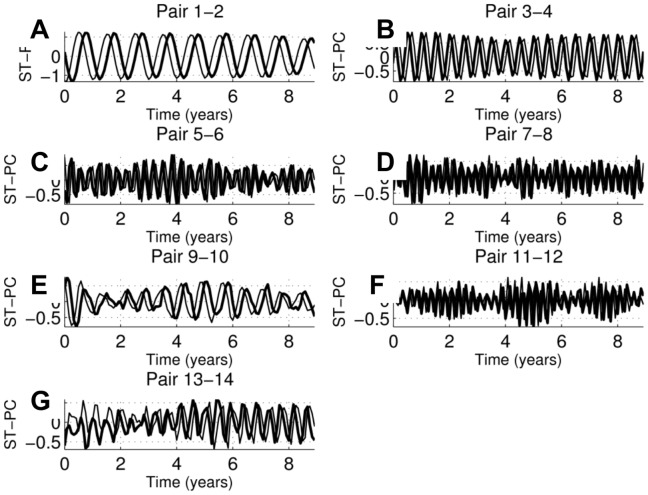
ST-PCs for consecutive MSSA components at channel 1; the ST-PCs span the window length N' = 108 months.